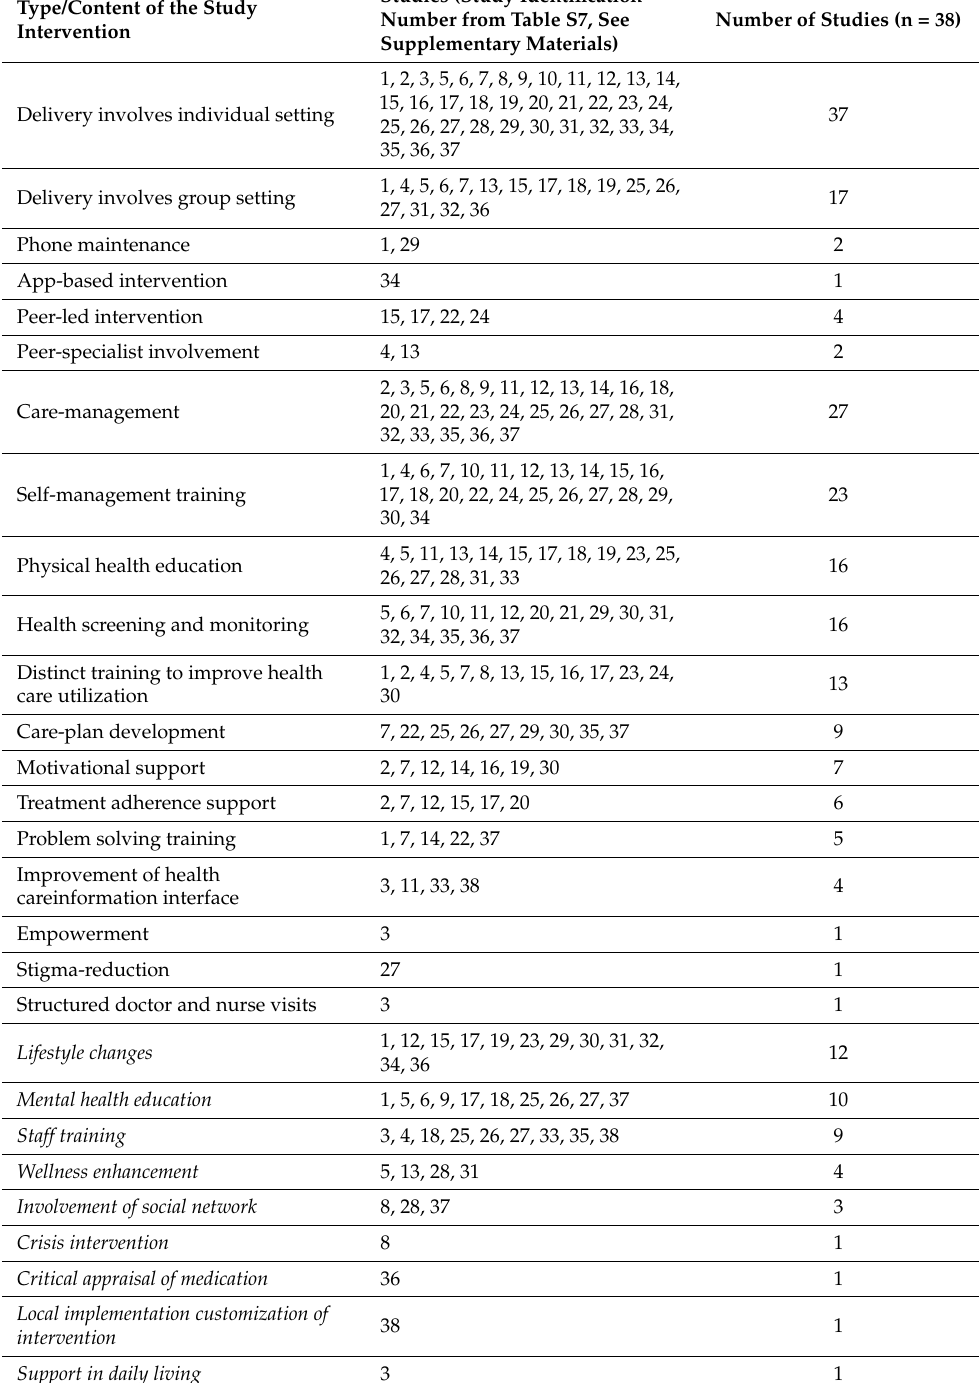
Table 1. Types and content of the interventions to promote the utilization of physical health services for people with a SMI. (Note: Additional interventions not predominantly targeting the utilization of physical health services are written in italics; listed types and content of interventions are not mutually